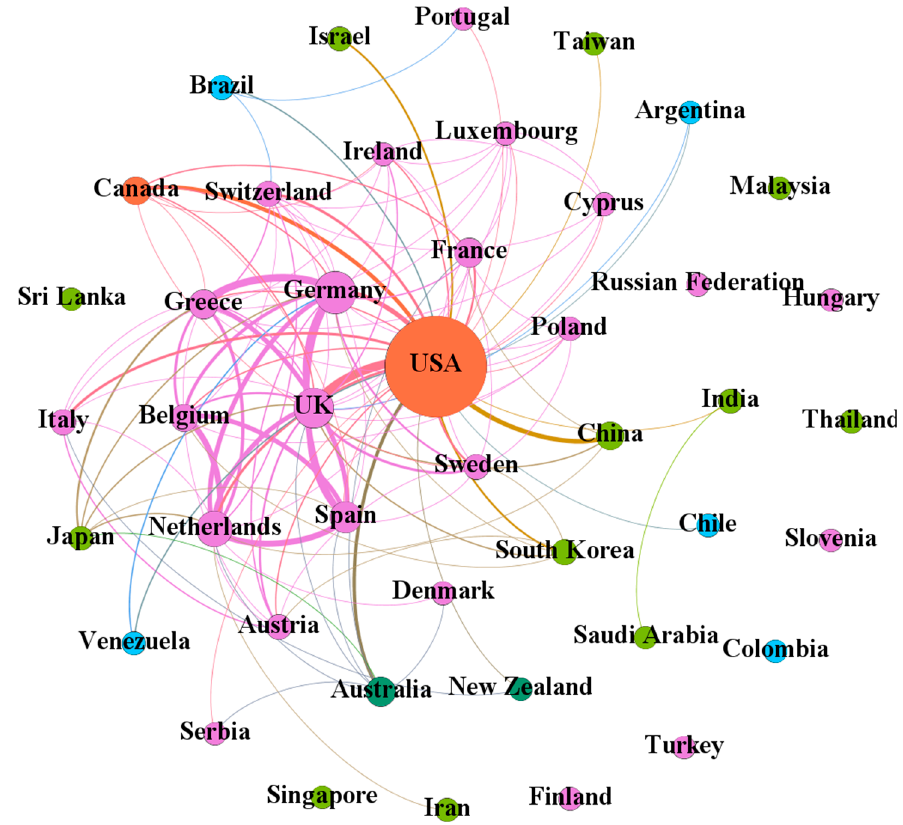
Figure 2. Collaboration network among countries/regions. Figure 3 shows the scientific collaboration network among 35 institutions (http://home.eduhk.hk/~hxie/applied_sciences/institutions.html) with an article count ≥ 5 and with 35